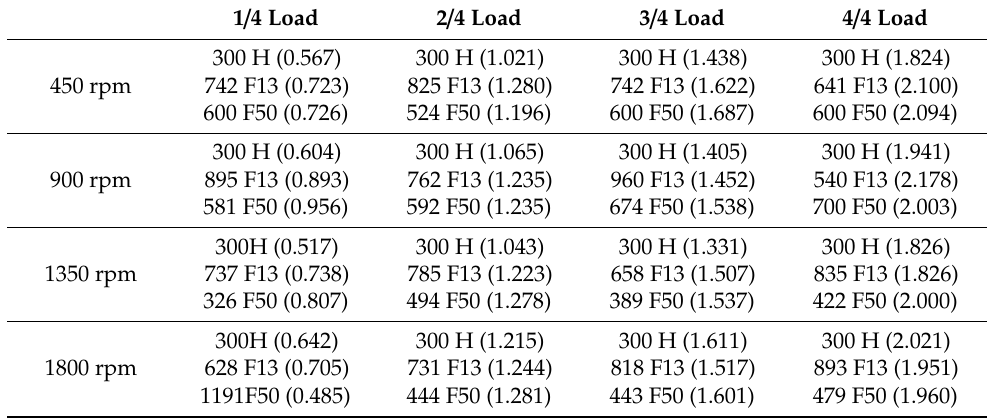
Table 1. Distribution of samples: the values in parenthesis show the average Root Mean Squared (RMS) values for each case.